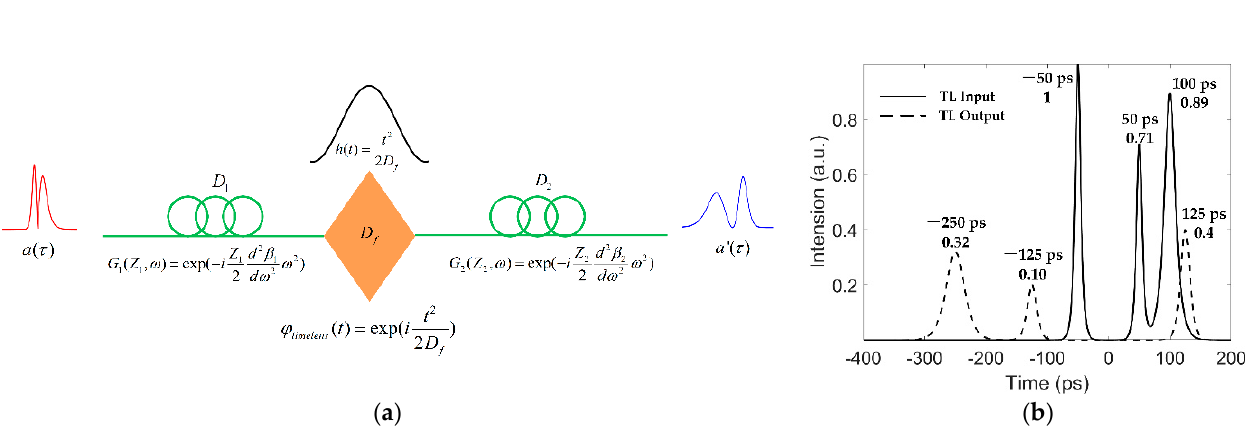
Figure 2. Time-lens principle and imaging of soliton pulses. ( a ) The imaging of the pulse by the time lens mainly comprises two dispersive fibers and the secondary phase modulation factors with respect to time t. a ( τ ) and a (cid:48) ( τ ) represent the pulse envelope before and after transmission through the time-lens, respectively. D 1 and D 2 represent two dispersion fibers. G 1 and G 2 are the transmission function of dispersive fibers 1 and 2 in the frequency domain, respectively. h ( t ) is a function with respect to the square of time, and constitutes the second order phase modulat or ϕ timelens ( t ) in the time-lens. ( b ) Example of time-lens imaging of pulse. The peak position (top) and normalized intensity (bottom) of each pulse are identified in the figure.